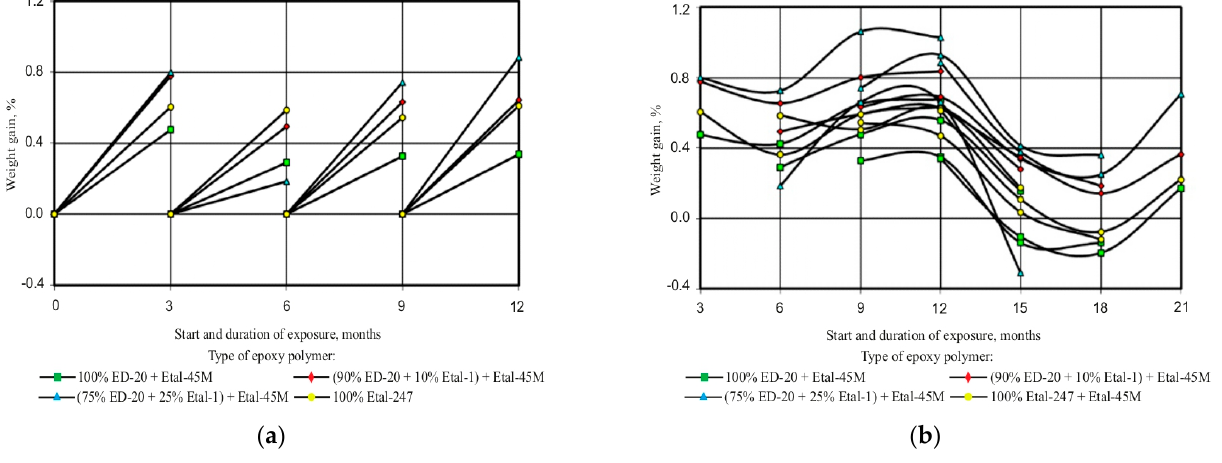
Figure 6. Change in the mass of the EP relative to the common time axis at the initial ( a ) and subsequent stages of exposure ( b ); ( a ) remaining 3 months and ( b ) remaining 9 months.